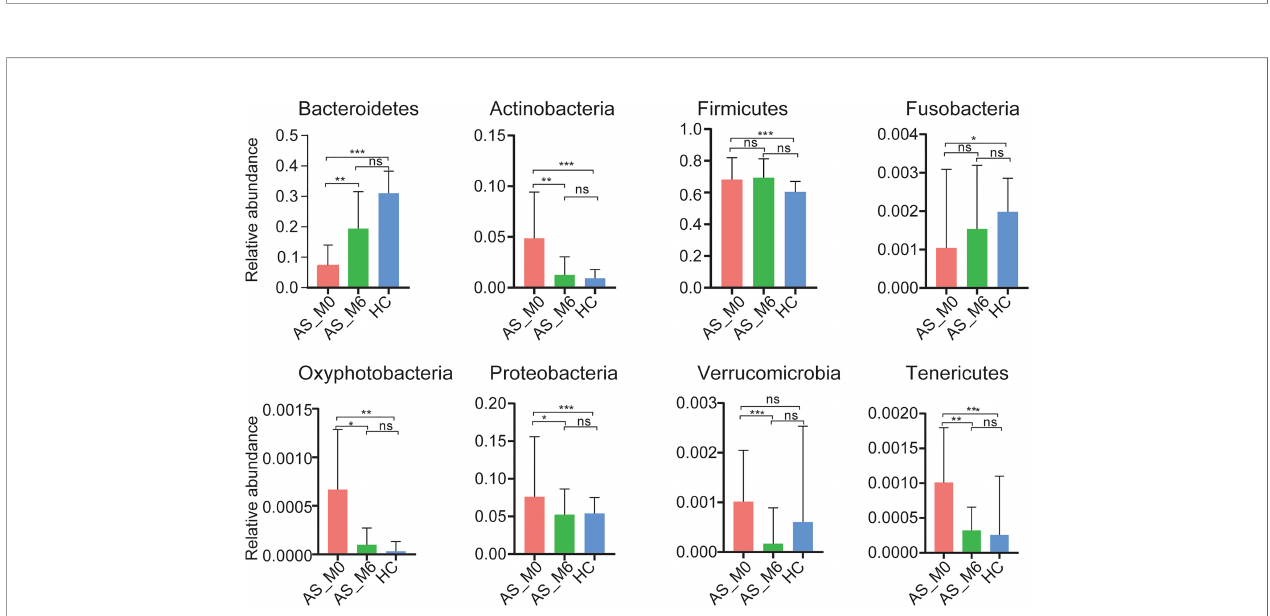
FIGURE 2 | Relative abundance of phyla in different groups. Bars represent the mean ± SEM. * P < 0.05, ** P < 0.01, *** P < 0.001, ns, P >